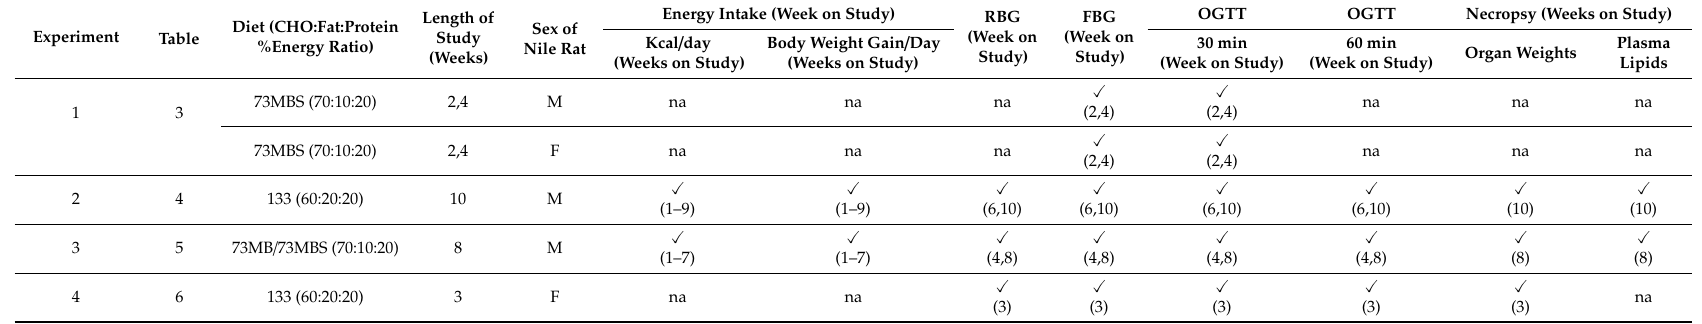
Table 2. Study Designs for Experiments 1–4 set to examine Genetic Permissiveness by using final quintiles of Blood Glucose. All Nile Rats were weaned at 3 weeks of age and studies varied from 2–10